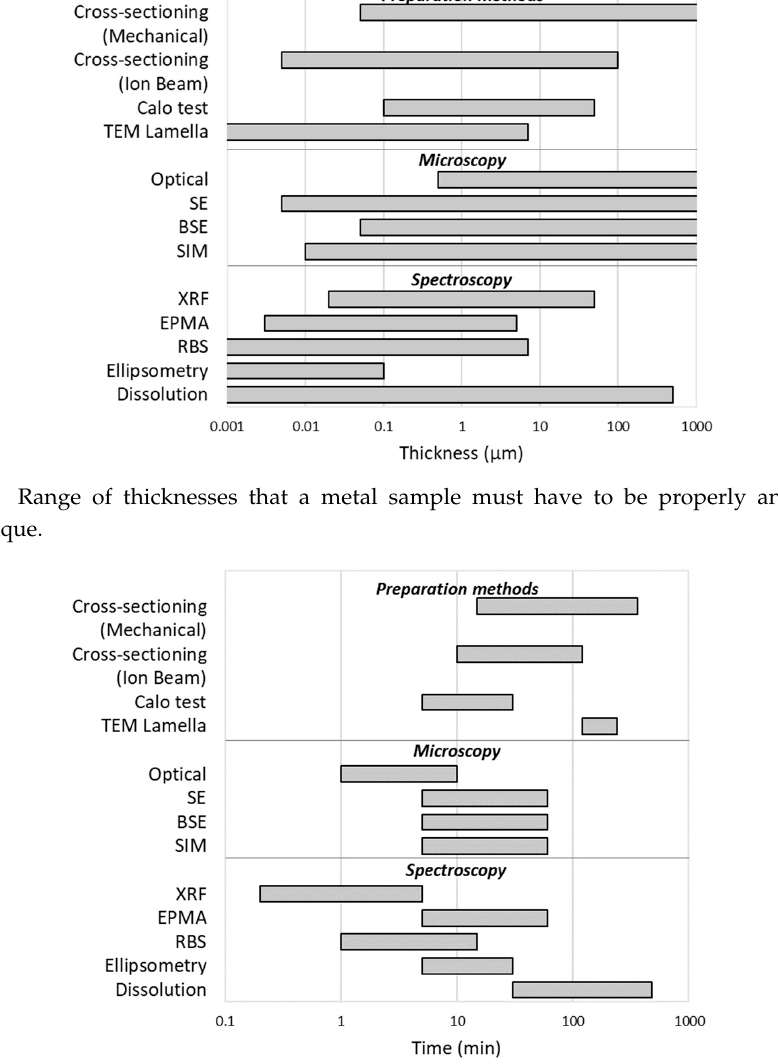
Figure 17. Time needed for the measurement and preparation of a sample for each technique.